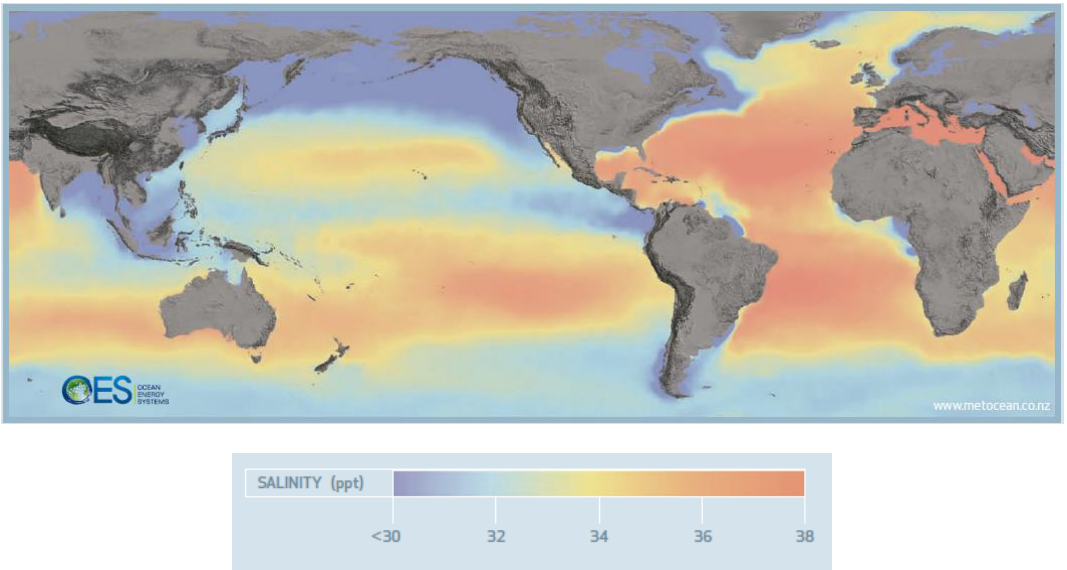
Figure 5. Salinity concentration in the world (Reproduced with permission from [42]. Ocean Energy Systems, 2011).